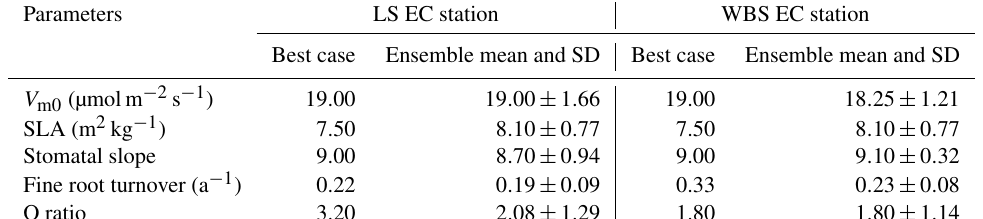
Table 6. Optimized parameter values from best cases and top 10 ensembles (mean and standard deviation (SD)) for LS and WBS EC stations.